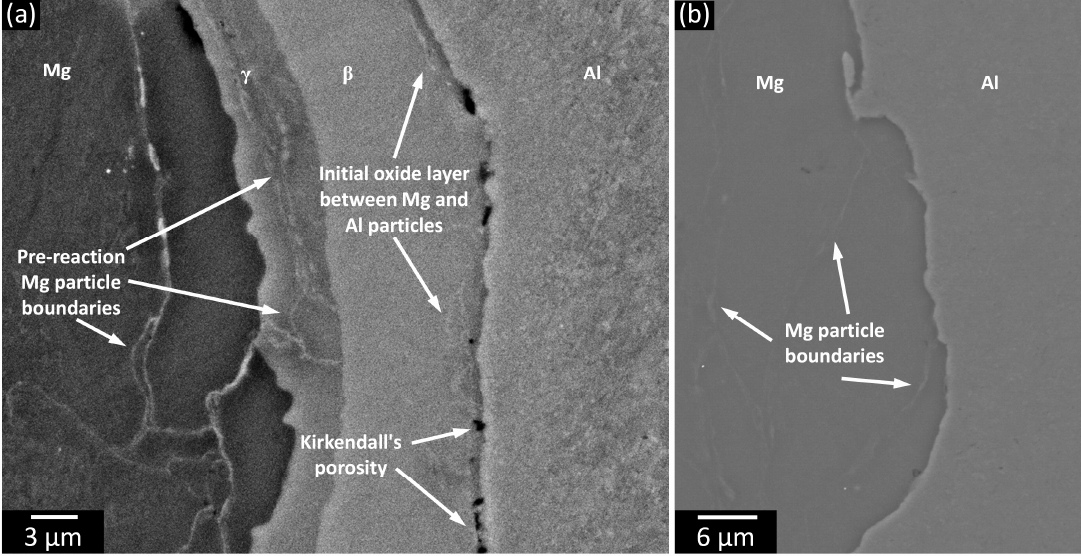
Figure 8. The SEM images of the Al-Mg interface in the bilayer composite hot-pressed at ( a ) 673 and ( b ) 573 K.